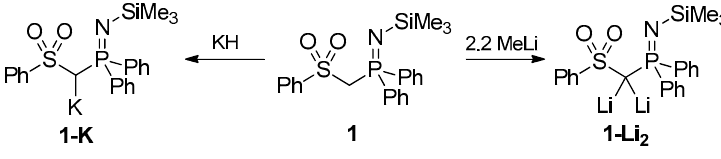
Figure 4. Synthesis of 1-K and 1-Li 2 .